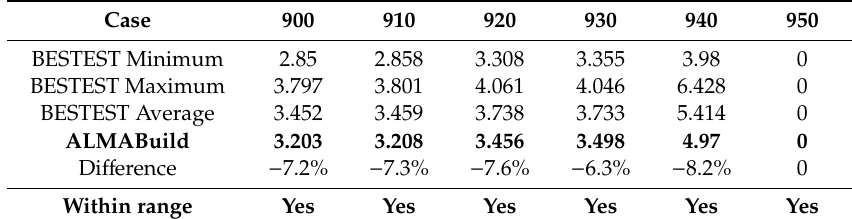
Table 9. Annual Heating Peak (kW) obtained for non-free-float heavyweight BESTEST cases compared with the minimum and maximum threshold values indicated by